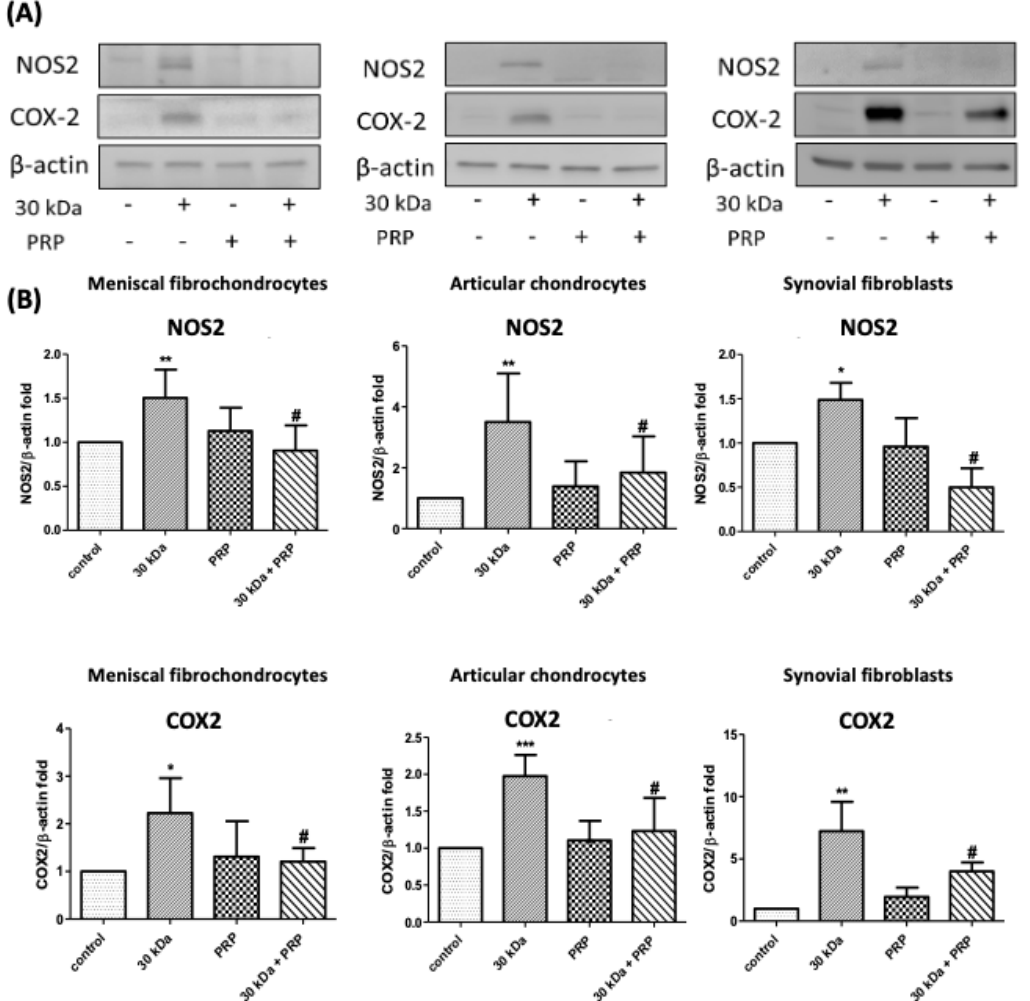
Figure 6. Effects of PRP on 30 kDa FN-f-induced COX2 and NOS2 protein expression in meniscal fibrochondrocytes, articular chondrocytes, and synovial fibroblasts. ( A , B ) PRP treatment suppressed upregulation of COX2 and NOS2 induced by 30 kDa FN-f (* p < 0.05, compared with control; ** p < 0.01, compared with control; *** p < 0.005, compared with control; # p < 0.05, 30 kDa + PRP vs. 30 kDa; n = 5 for each group).